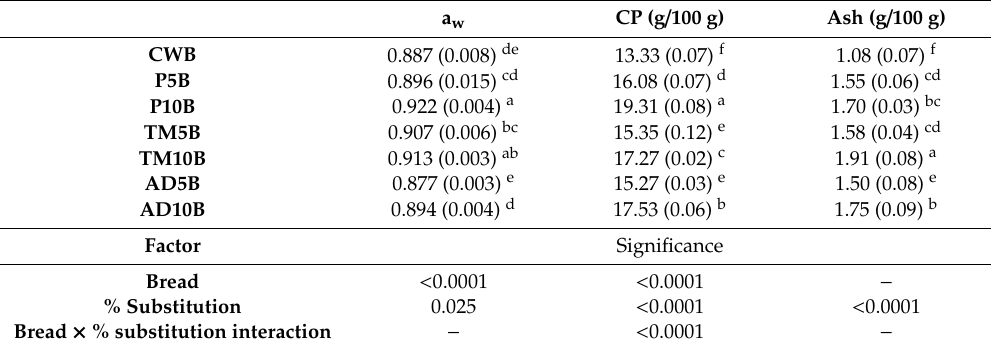
Table 2. Mean values (and standard deviations) of water activity, crude protein, and ash content of